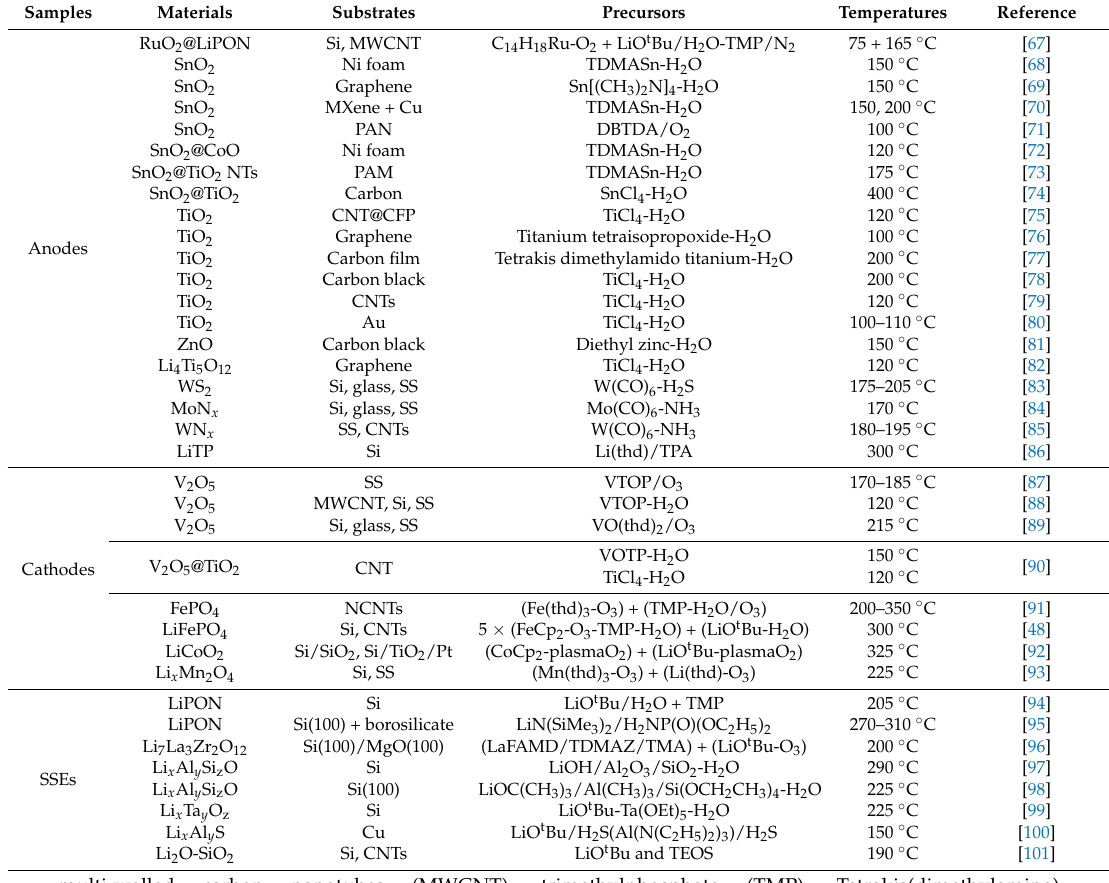
Table 1. Summary of anodes, cathodes, and solid-state electrolytes (SSEs) fabricated via the atomic layer deposition (ALD) for lithium-ion batteries